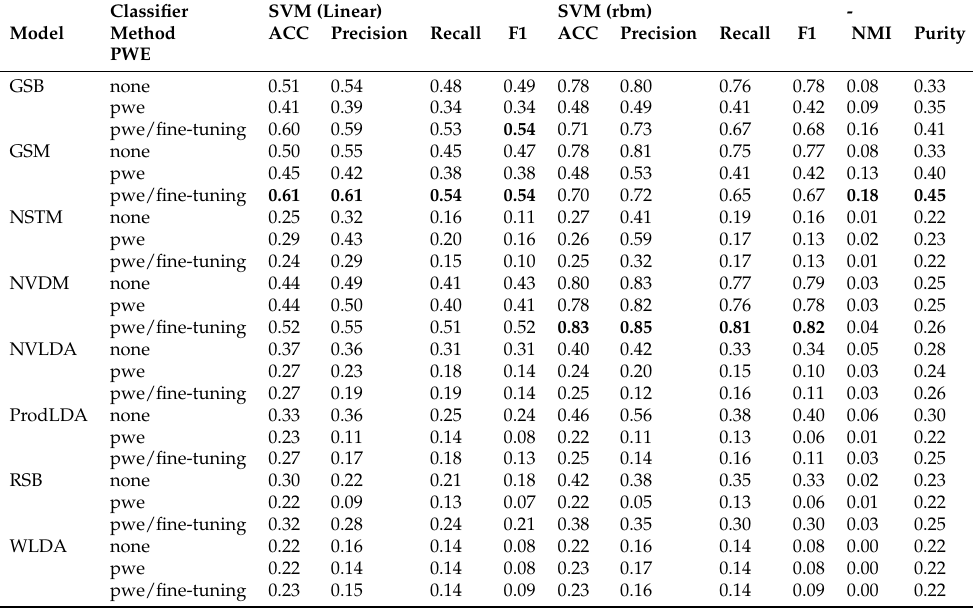
Table 30. Classification and Clustering performance on SearchSnippets.